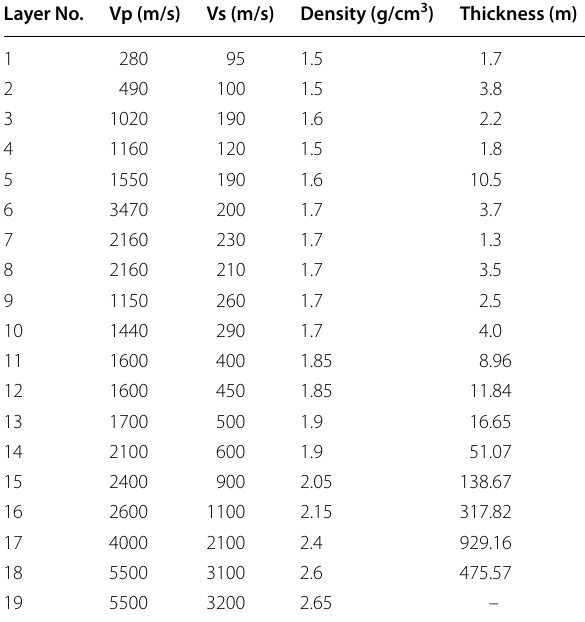
Table 3 Velocity model; preferred model based on OYO ground investigation provided by the organizing committee Layer